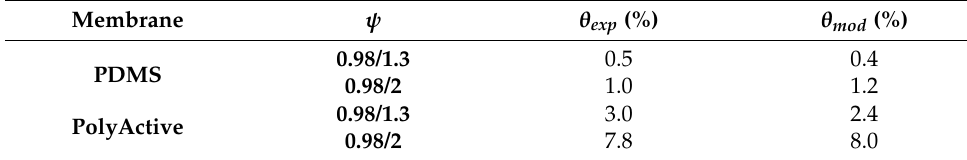
Table 2. Experimental and modeled stage cuts for different values of ψ